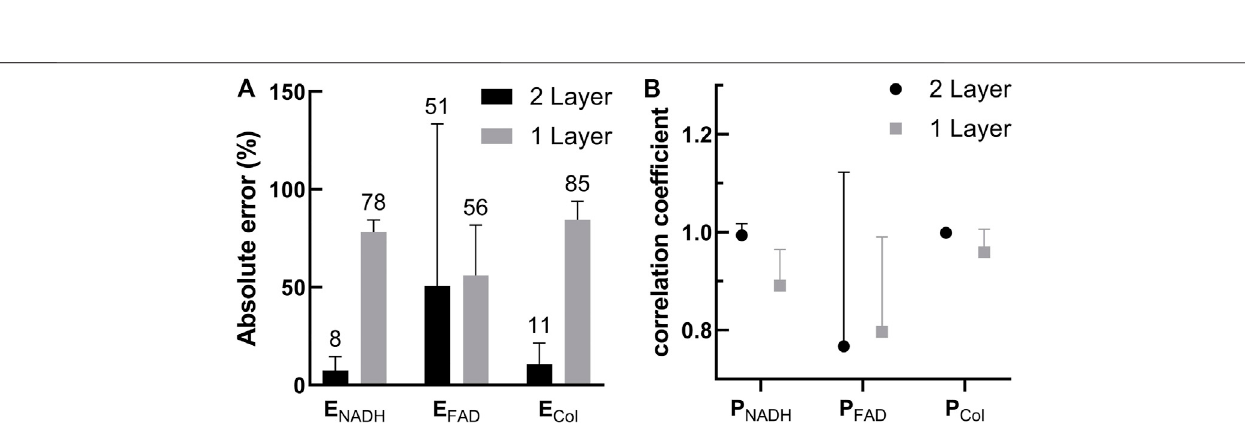
FIGURE 6 | (A) Comparison between errors in the fl uorescence ef fi ciency of the three fl uorophores extracted by the two-layer and one-layer forward models (B) Correlationcoef fi cientsbetweentheextracted P fl ( λ )andthe P fl ( λ )usedtogeneratethetargetspectra.Resultsforthethree fl uorophoresobtainedusingthetwo-layerand one-layer forward models are plotted for